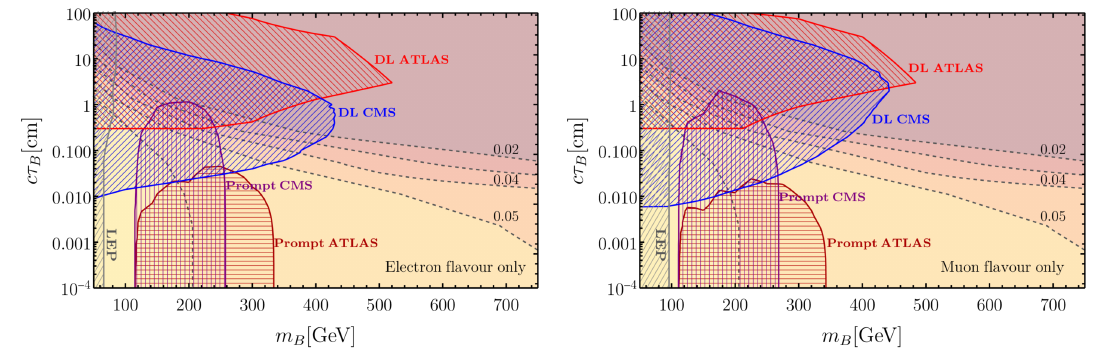
Figure 4 . Collider constraints on the parameter space of interest in the case of B only coupling to a single flavour. On the left for coupling to electrons only ( y coupling to muons only ( y